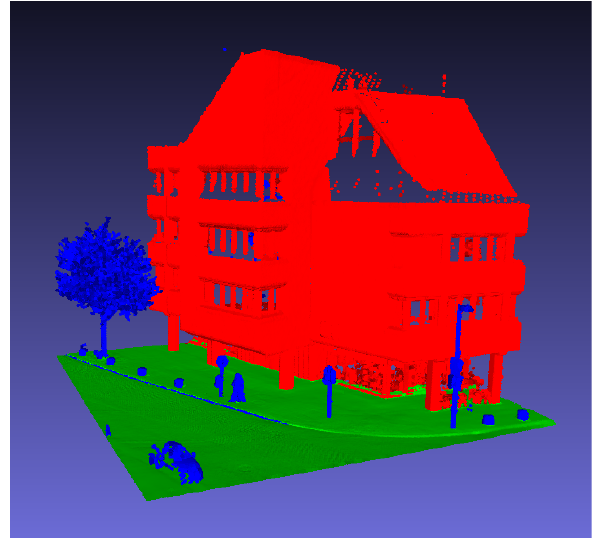
Figure 4. Classified point cloud - ground (green) - building (red) - occluders (blue)